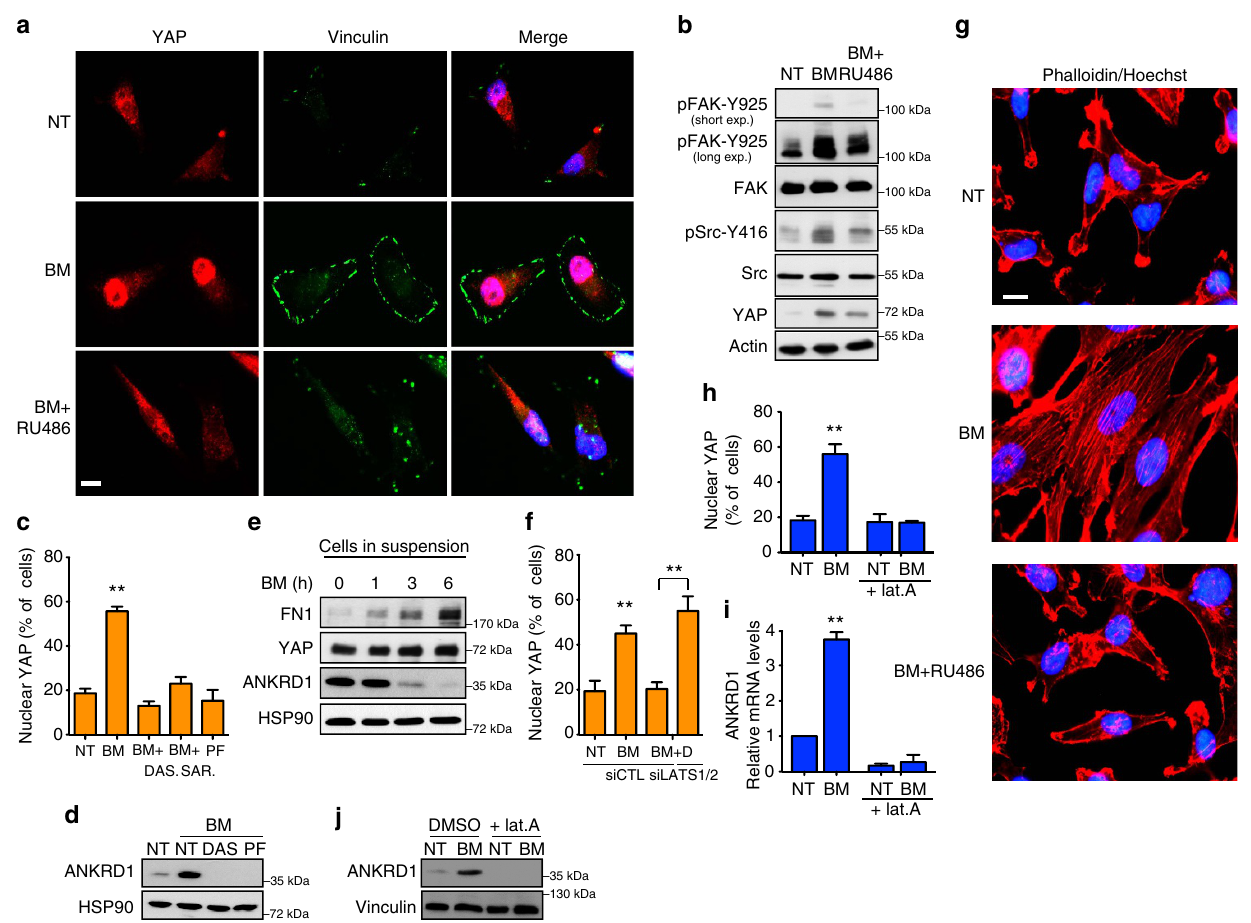
Figure 5 | Glucocorticoids activate YAP via FAK/Src-dependent actin cytoskeleton remodelling. ( a ) MDA-MB-231 cells were grown in serum-free medium and treated with betamethasone (BM) 1 m M alone or in combination with RU486 1 m M for 24h. Representative images of immunofluorescence are shown. Experiment repeated three times. Scale bars, 15 m m. ( b ) MDA-MB-231 cells were treated as in a . Representative blots are shown. Experiment repeated three times. ( c ) Quantification of MDA-MB-231 cells with nuclear YAP by immunofluorescence. Cells were grown in serum-free medium in presence of BM 1 m M alone or in combination with dasatinib (DAS) 0.1 m M or saracatinib (SAR) 0.1 m M or PF573228 (PF) 5 m M for 24h. Error bars represent mean ± s.d., from n ¼ 3 biological replicates. ( d ) MDA-MB-231 cells were grown in serum-free medium in presence of BM 1 m M alone or in combination with DAS 0.1 m M or PF 5 m M for 24h. Representative blots are shown. Experiment repeated three times. ( e ) MDA-MB-231 cells were trypsinized and then maintained in suspension and treated with BM 1 m M for indicated times. Representative blots are shown. ( f ) Quantification of MDA-MB-231 cells with nuclear YAP by immunofluorescence. Cells were transfected with control siRNA (siCTL) or a combination of siRNA targeting LATS1 and 2 (siLATS1/2). The day after cells were grown in serum-free medium in presence of BM 1 m M alone or in combination with DAS 0.1 m M for 24h. Error bars represent mean ± s.d., from n ¼ 3 biological replicates. ( g ) Representative images of immunofluorescence. MDA-MB-231 cells were grown in serum-free medium and treated with BM 1 m M alone or in combination with RU486 1 m M for 24h. Experiment repeated three times. Scale bars, 15 m m. ( h ) Quantification of MDA-MB-231 cells with nuclear YAP by immunofluorescence. Cells were grown in serum-free medium in presence of BM 1 m M alone or in combination with latrunculin A (lat.A) 0.5 m M for 24h. Error bars represent mean ± s.d., from n ¼ 3 biological replicates. ( i ) Quantitative PCR